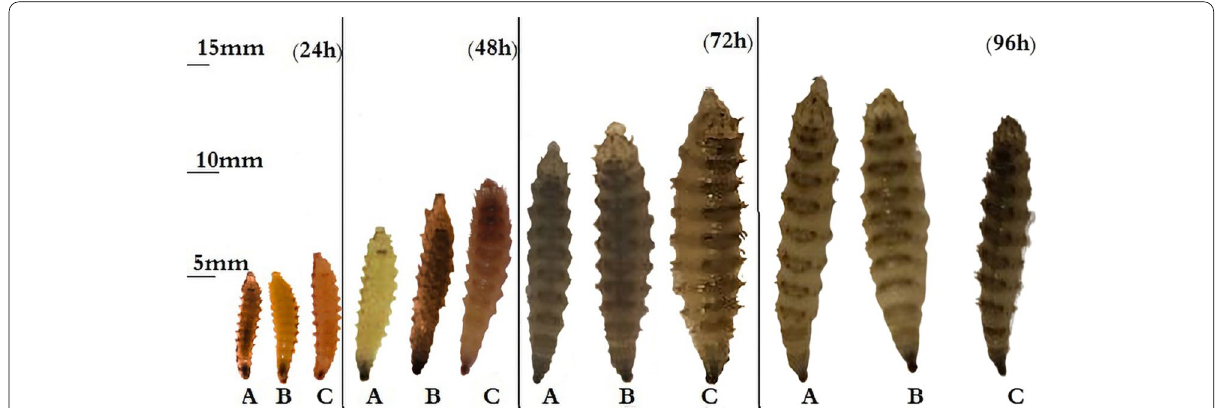
Fig. 1 Comparison of body length of larvae after 24, 48, 72 and 96 h of C. albiceps at different temperatures A 20 °C, B 25 °C, and C 30 °C